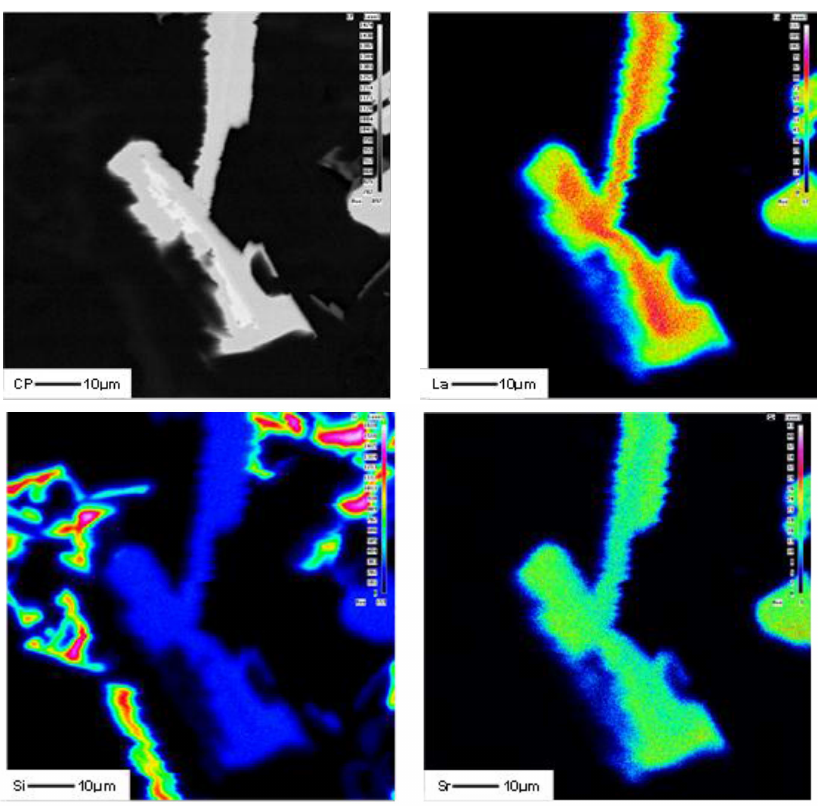
Figure 9. Ce-Sr interactions in A356 alloy modified with 1.0% Ce + 0.01% Sr (T5S alloy).